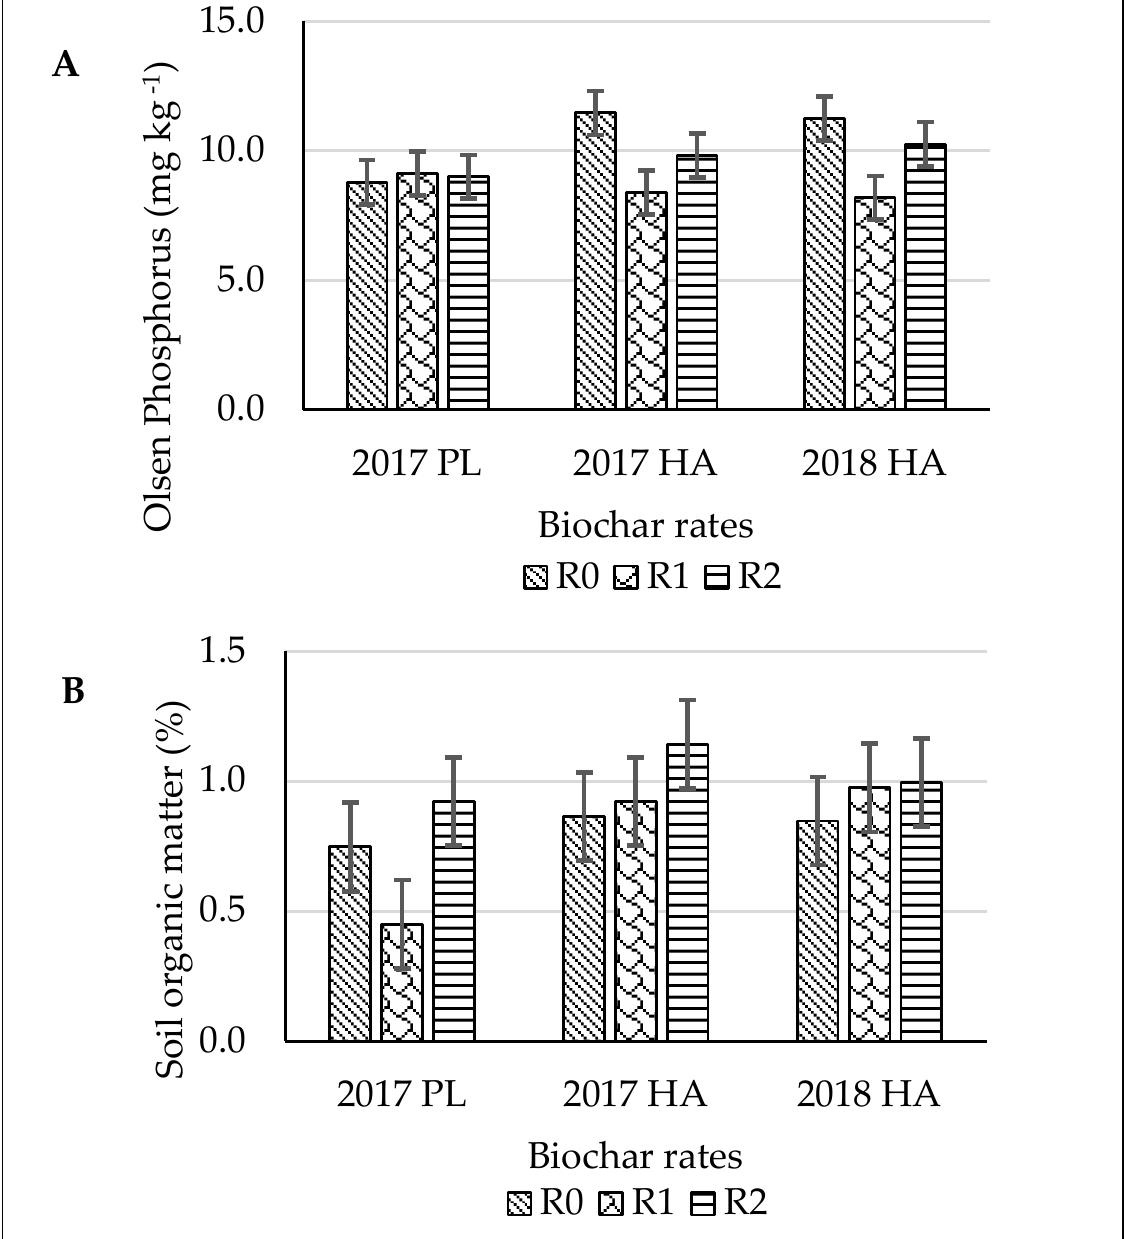
Figure 3. Mean values of soil Olsen P in pinto bean soil ( A ) and soil organic matter in sorghum–Sudan soil ( B ) as a function of biochar rates and sampling time. Biochar rates for pinto bean: 0 Mg ha − 1 (R0), 2.2 Mg ha − 1 (R1), and 11.2 Mg ha − 1 (R2). Biochar rates for sorghum–Sudan: 0 Mg ha − 1 (R0), 3.4 Mg ha − 1 (R1), and 6.7 Mg ha − 1 (R2).